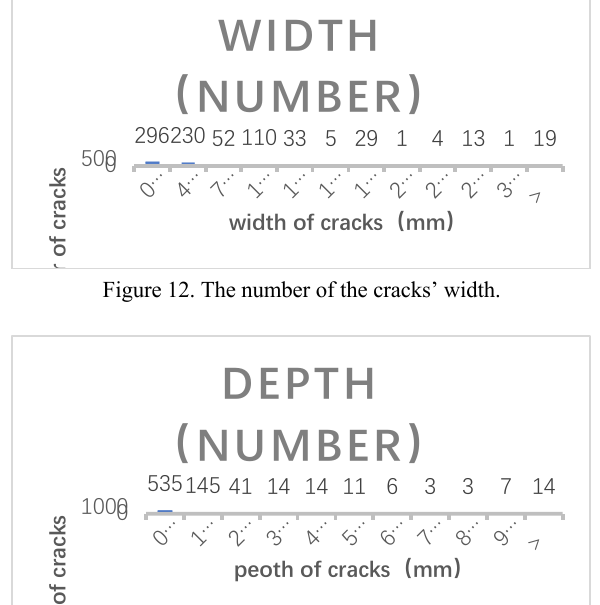
Figure 13. The number of the cracks’ depth.